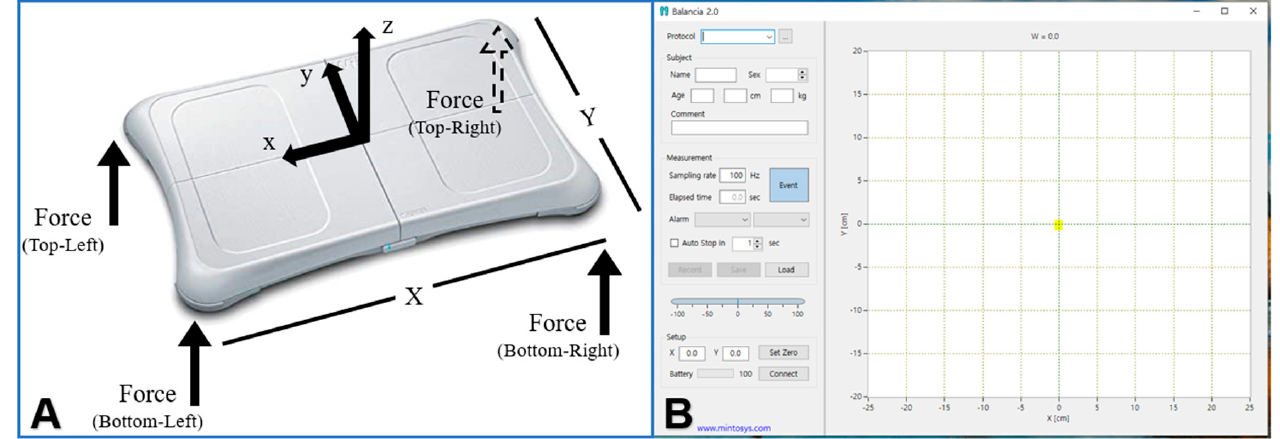
Figure 3. Static balance ability and weight bearing rate measurement tool (( A ) Wii balance board, ( B ) Balancia software ver 2.0).